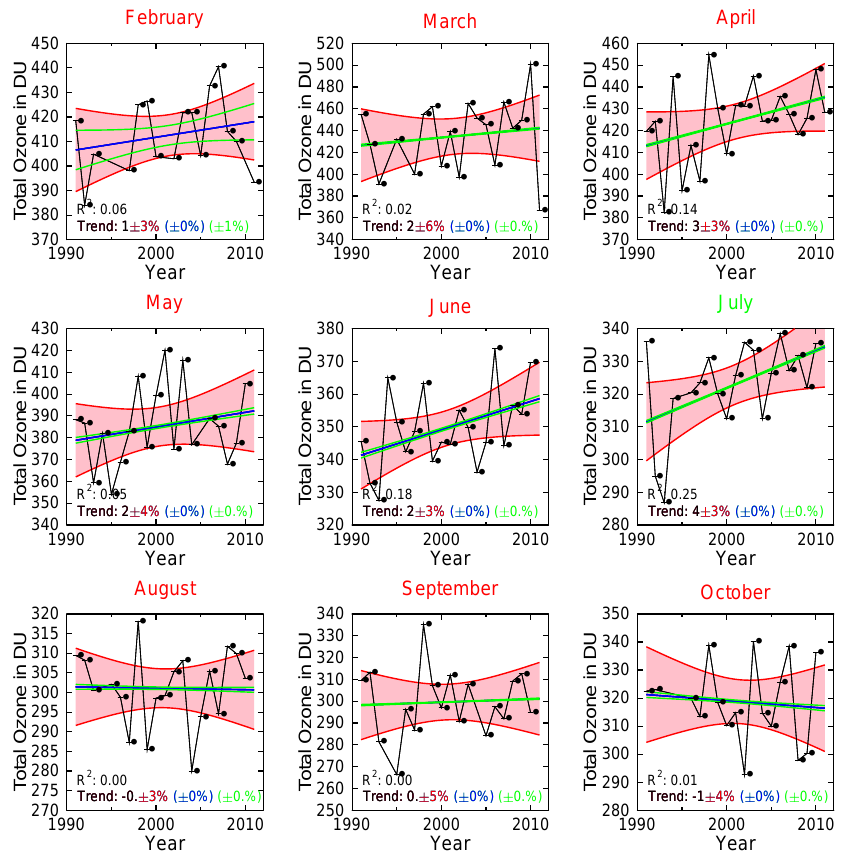
Fig. 6. Same as Fig. 2, but for total ozone. The measurement uncertainty was set to zero.